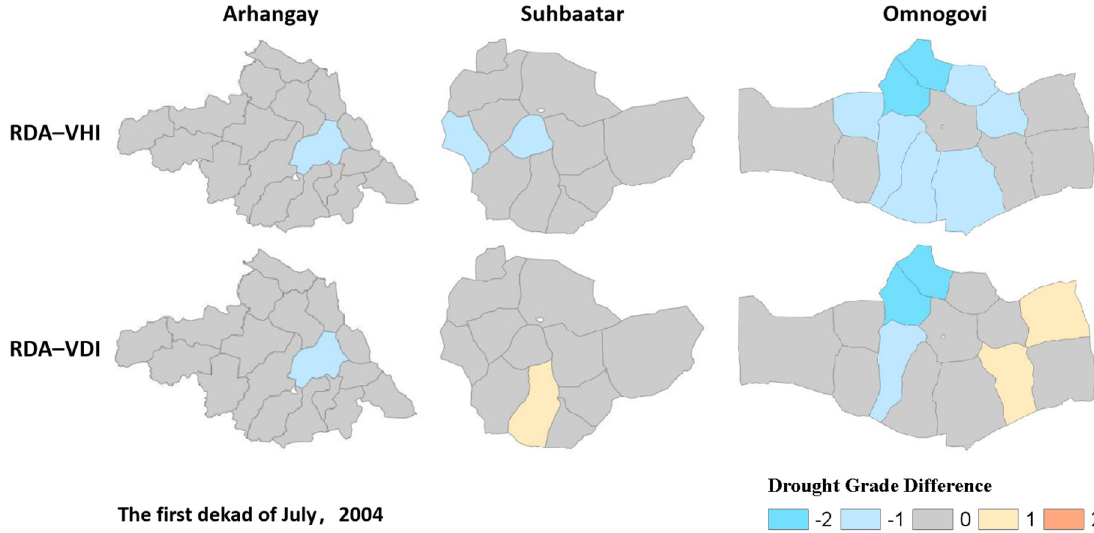
Figure 9. Drought grade differences for the averaged VHI, VDI, and RDA (RDA–VHI, RDA–VDI) at the county level in the first dekad of July, 2004, for three typical provinces.